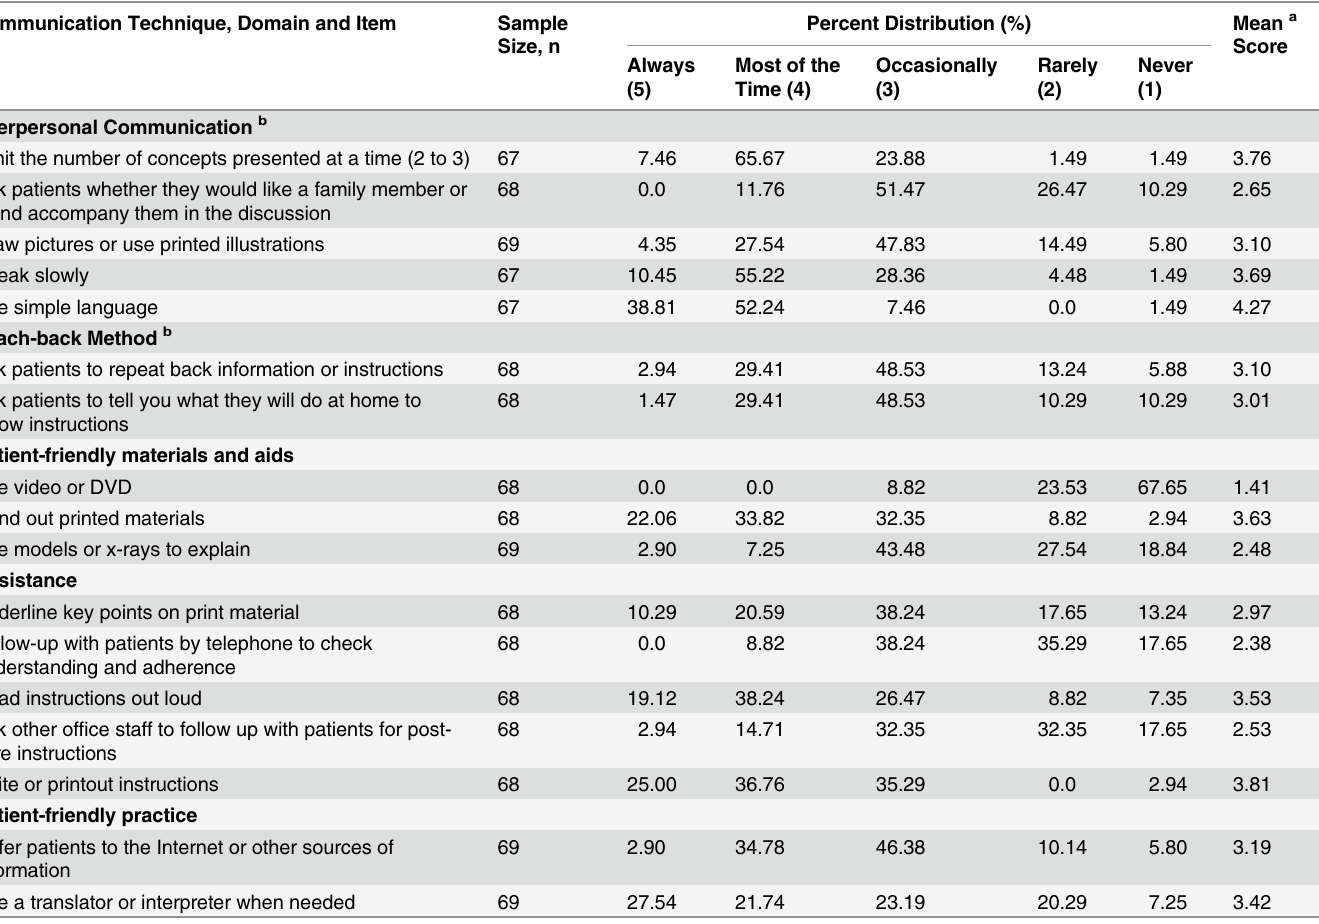
Table 2. Percentage distribution of techniques used routinely by family physicians and mean Likert scale scores.